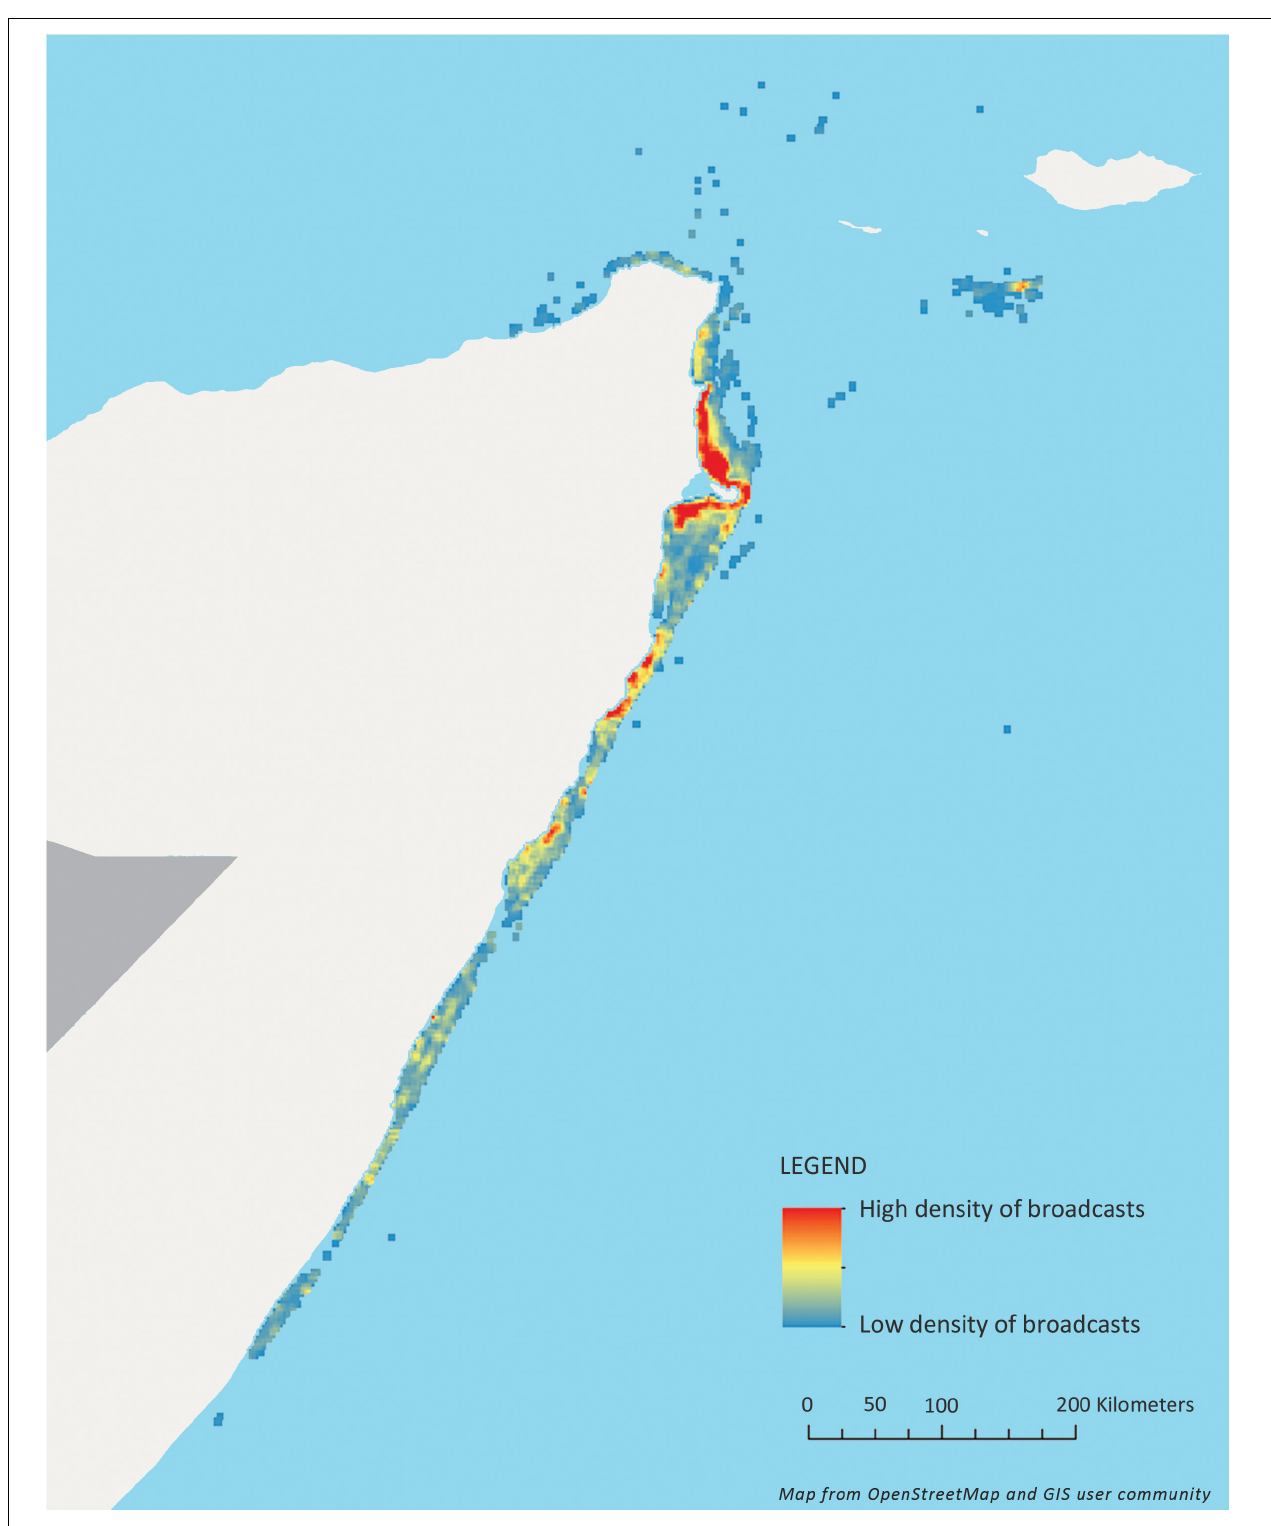
FIGURE 3 | Density of AIS pings during active bottom trawling from seven South Korean-flagged trawlers during 2010–2014.